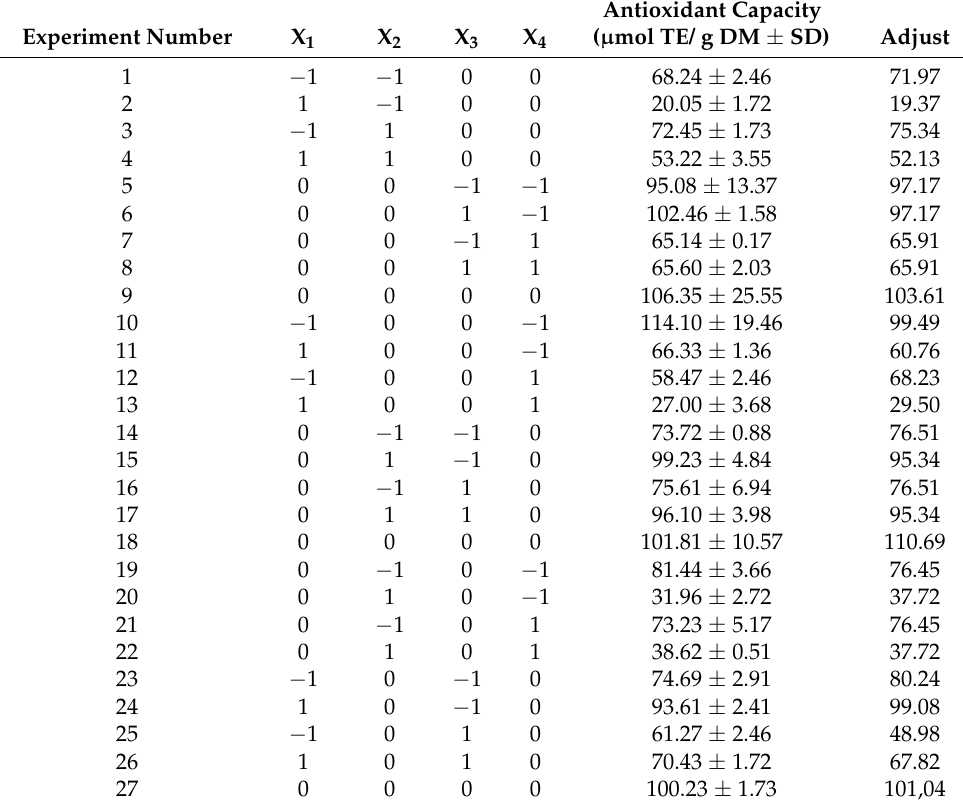
Table 1. Data matrix of Box-Behnken design for extraction of antioxidants from hibiscus calyxes.